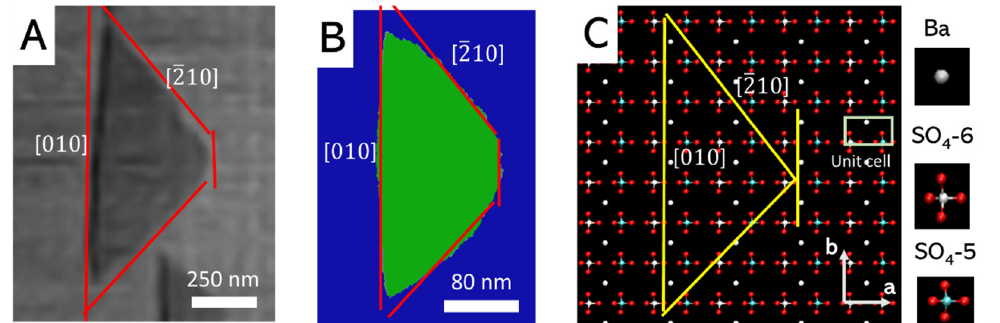
Figure 5. Morphology of monolayer pits on barite surface. ( A ): Experimental data [14] (Kuwahara, Y, In situ hot-stage AFM study of the dissolution of the barite (001) surface in water at 30–55 °C (2012), Am. Min., 97, 1564–1573, Copyright (2012), MSA, reproduced with the permission of the Mineralogical Society of America); ( B ): KMC simulations (this work, the parameter Set IV in the Table 1); ( C ): Primary crystallographic directions on the barite (001) face, white atoms in SO 4 groups correspond to 6-coordinated sites, while cyan atoms correspond to the 5-coordinated sites.